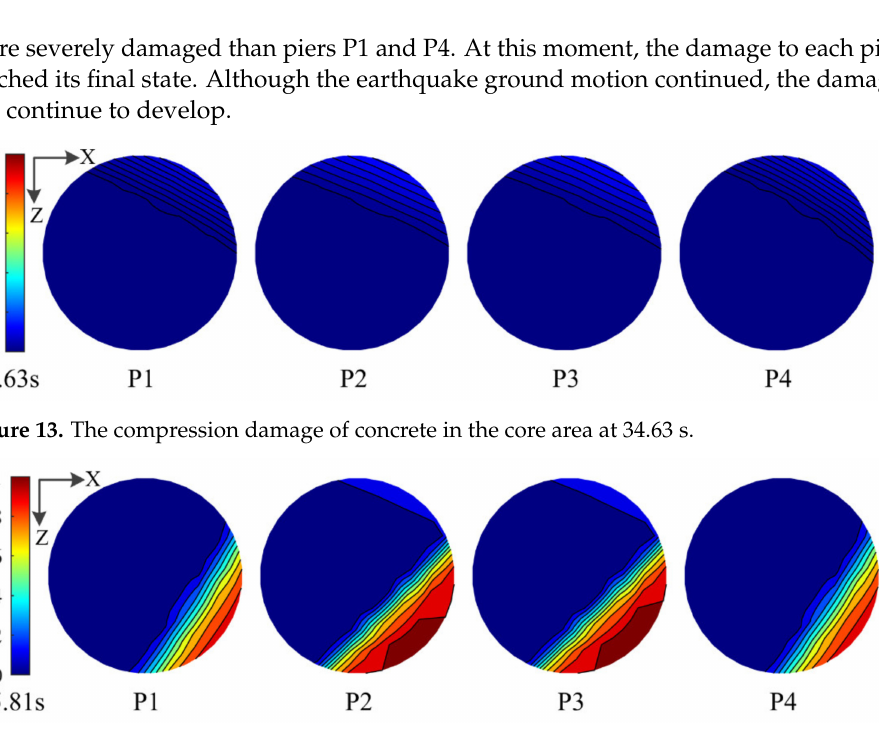
Figure 14. The compression damage of concrete in the core area at 35.81 s.